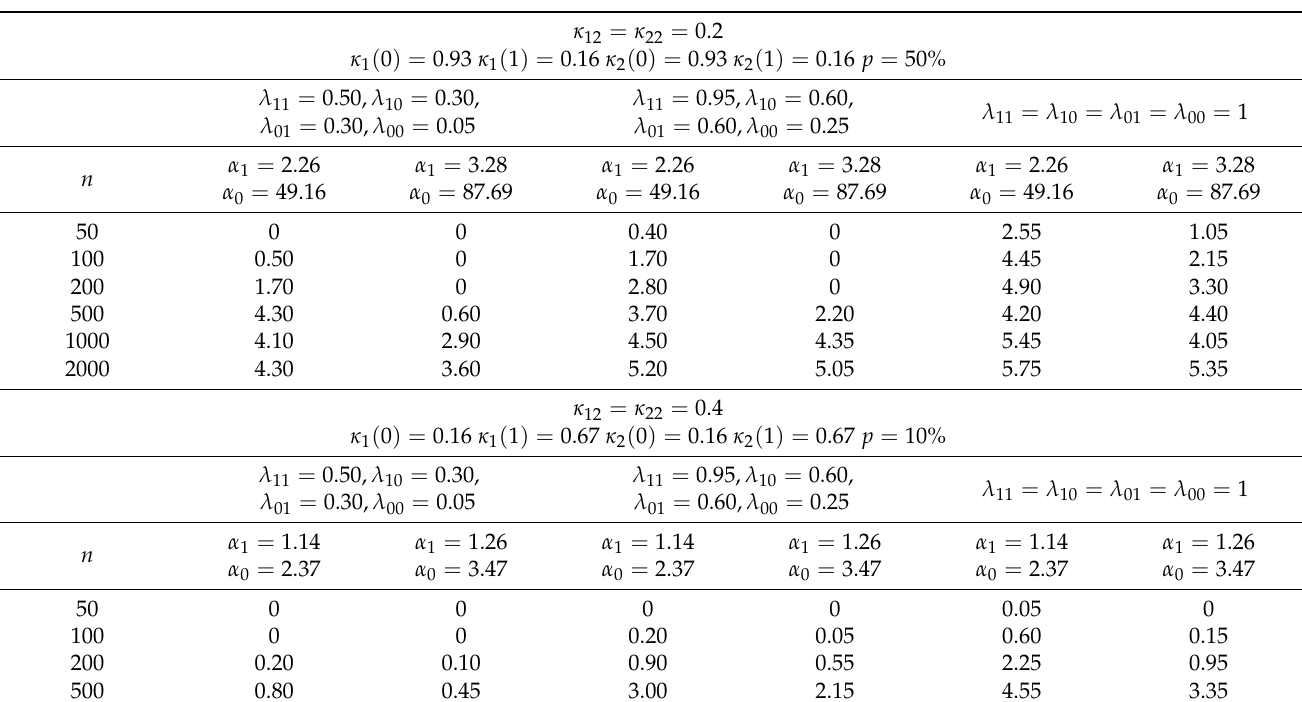
Table 4. Type I error (in %) of the hypothesis test when L > L (cid:48) (0.5 < c ≤ 1). κ 12 = κ 22 =